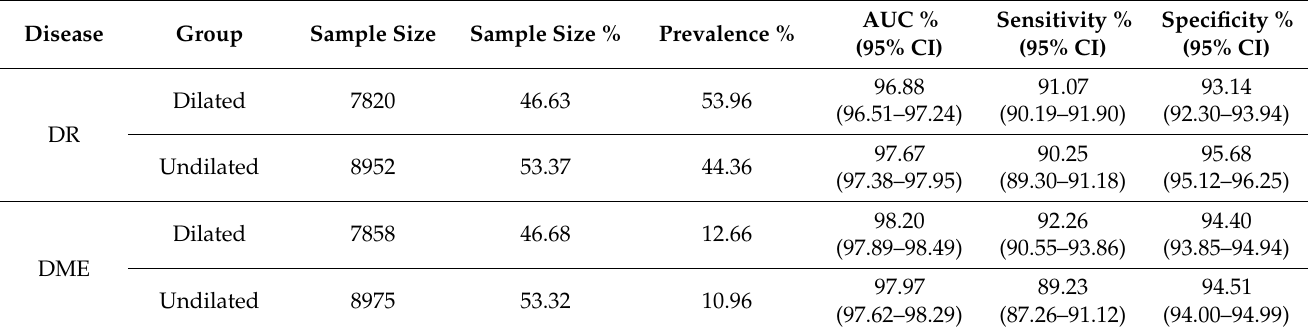
Table A8. Stratification results for the detection of referable retinopathy and diabetic macula edema on the patient level for dilation